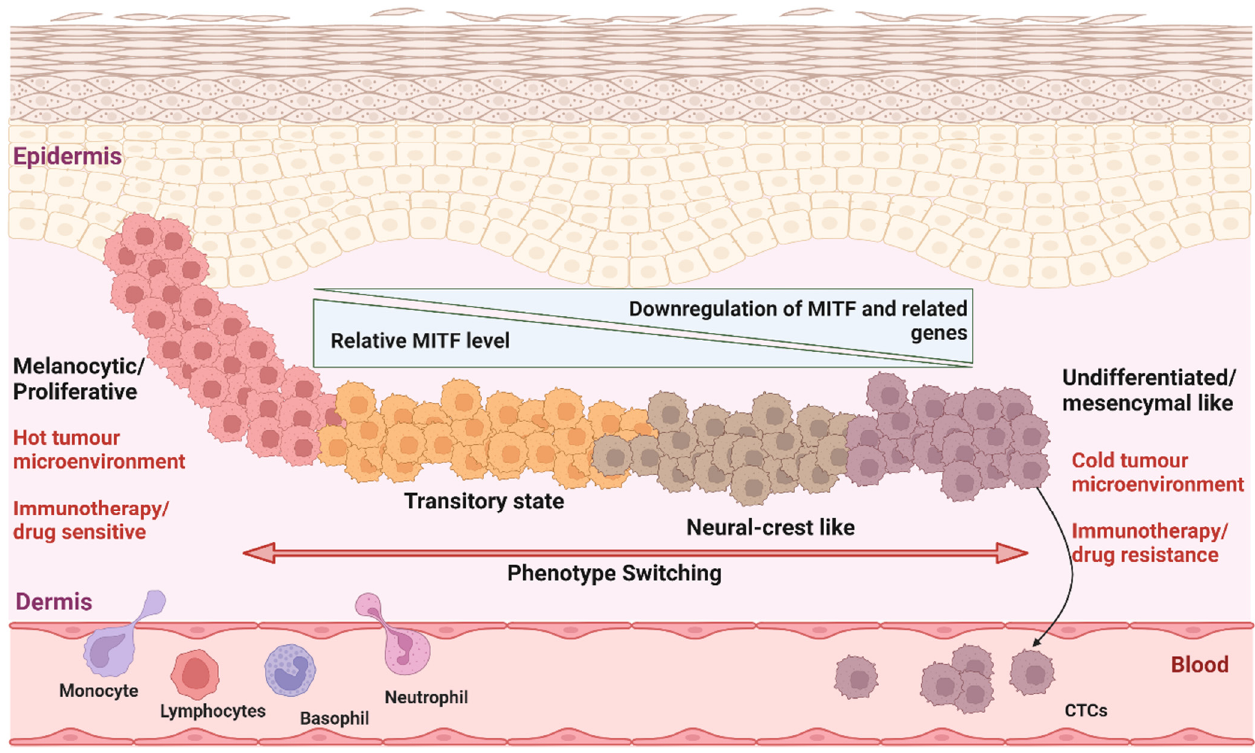
Figure 1. Depiction of phenotype switching during melanoma progression and the development of immunotherapy and drug resistance, based on the expression of MITF and MITF -related genes in the same tumor bed. Melanoma cells expressing low levels of MITF correspond to a slow-cycling and pro-invasive state (similar to “mesenchymal-like”), whereas higher levels of expression of MITF correlate with a proliferative and melanocytic state. Undifferentiated melanomas/neural-crest like (on the right side) melanomas lack activated immune cells, while melanocytic melanomas (left side) are composed of immunologically relatively more active immune cells/hot tumor microenvironment, which is also associated with melanocytic melanomas being relatively more responsive to immunotherapy or targeted drugs.